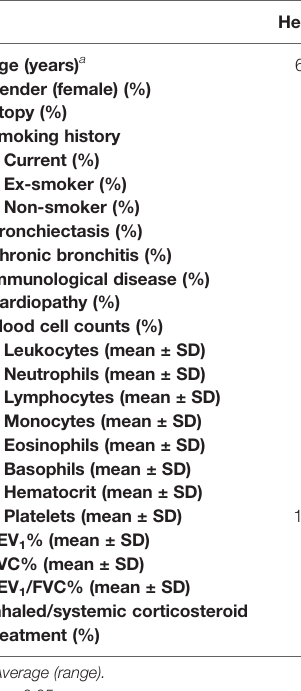
TABLE 1 | Demographic and clinical data of subjects from whom biopsies were